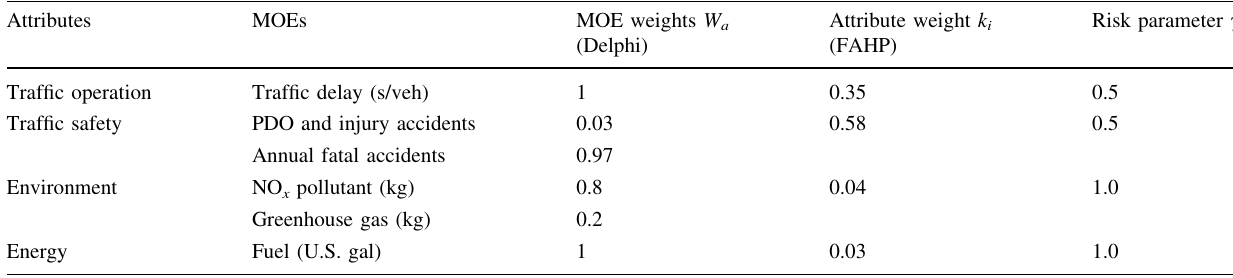
Table 4 Summary of weights and risk parameter assignments